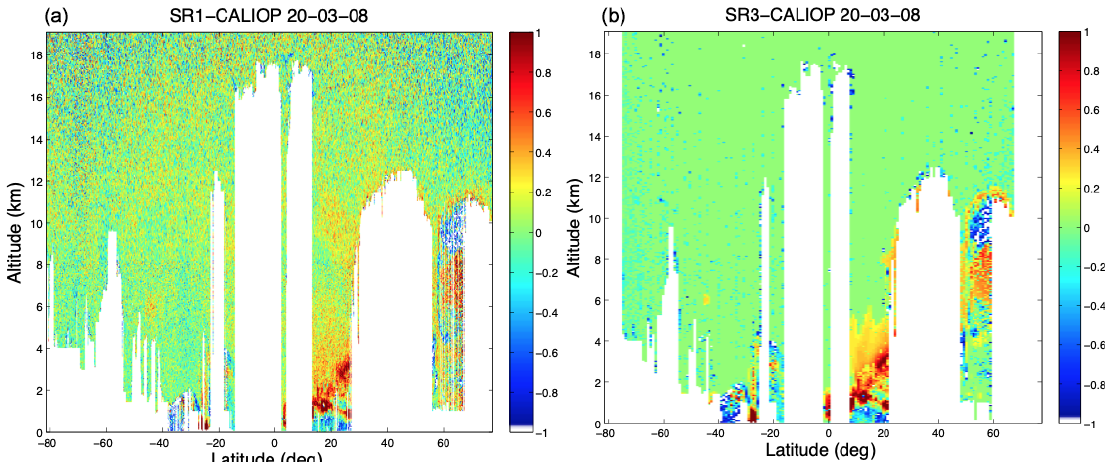
Figure 6. (a) Difference between model SR_masked and CALIOP data before data processing; (b) difference between model SR_observable and CALIOP data after data processing (see text for details) along the satellite orbit on 20 March 2008.